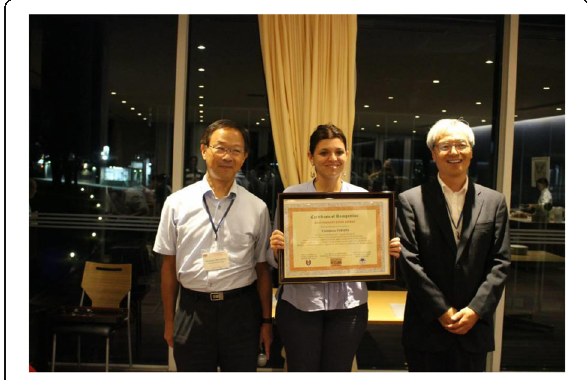
Fig. 7 Winner of the Best Presentation Award of the 15